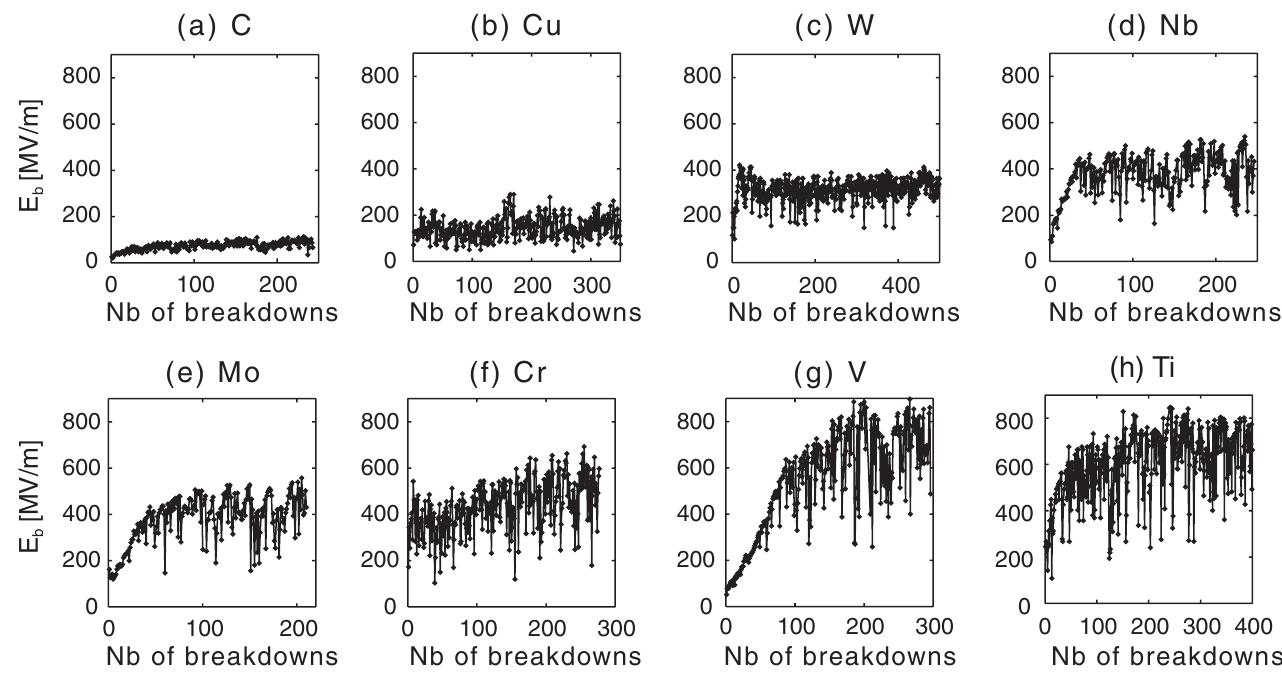
FIG. 2. Conditioning curves of pure metals. The metals are ranked according to their saturated breakdown